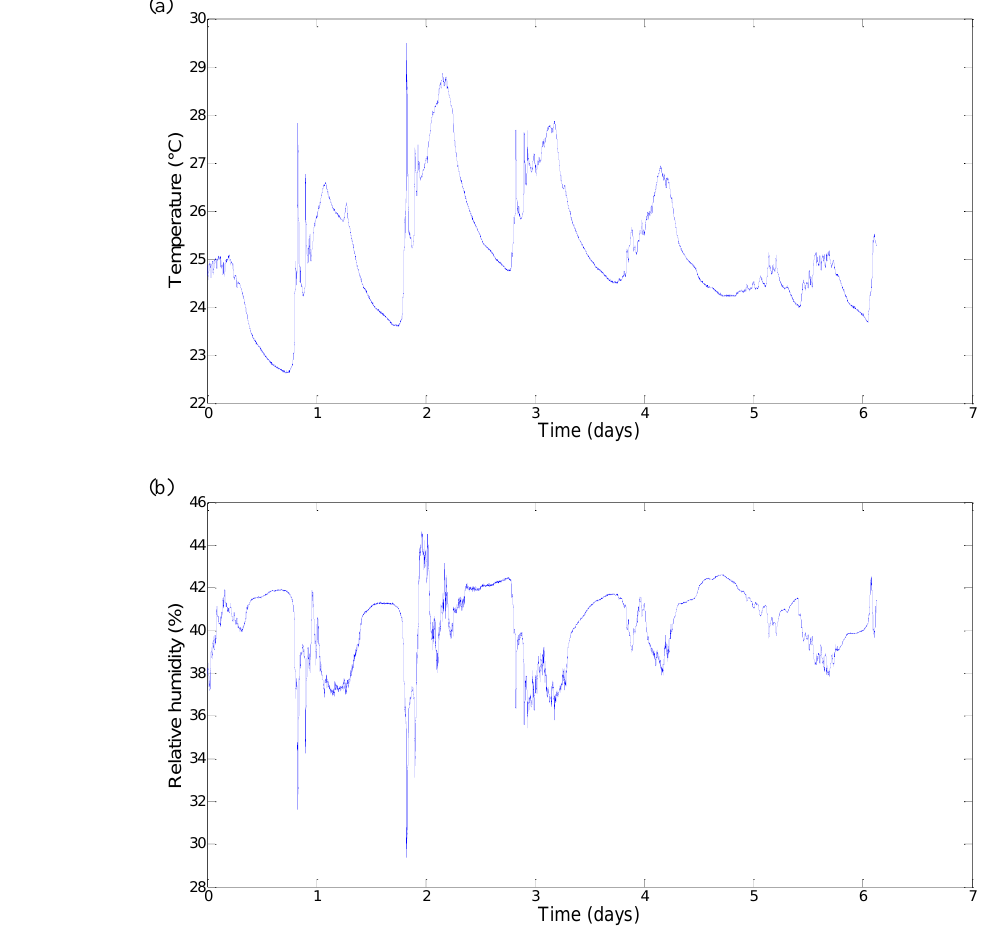
Figure 5. (a) Temperature measured by the autonomous platform. (b) Relative humidity measured by the autonomous platform.